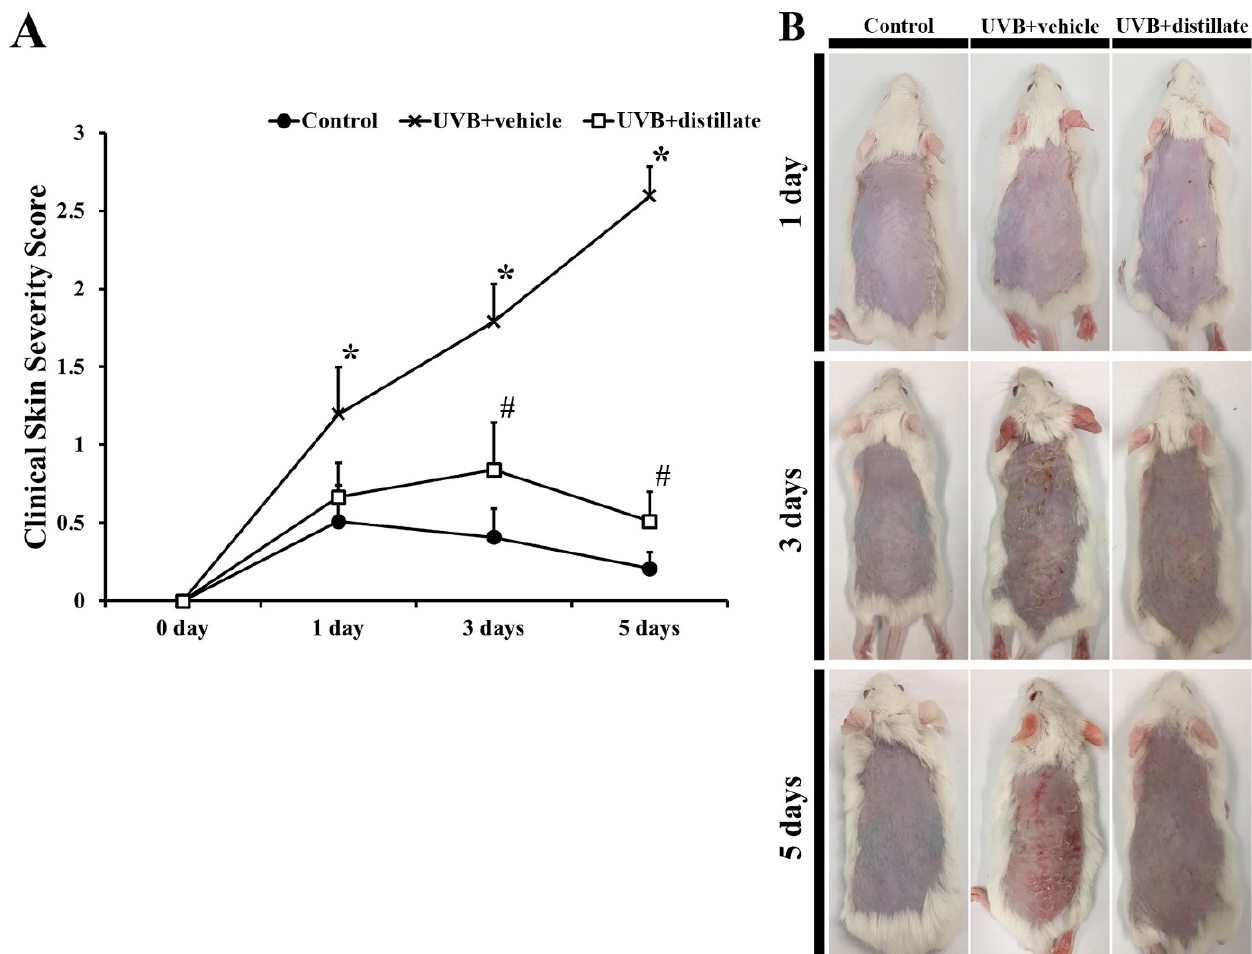
Figure 2. ( A ) The clinical skin severity score observed in the control, UVB + vehicle, and UVB + distillate groups at 1 day, 3 days, and 5 days after UVB exposure. The clinical skin severity score in the UVB + vehicle group was significantly increased from 1 day after UVB irradiation, however, the score in the UVB + distillate group was significantly decreased from 3 days to 5 days after UVB exposure compared to that in the UVB + vehicle group. The data represent mean ± standard errors of means ( n = 10/group, * p < 0.05 vs. control group; # p < 0.05 vs. UVB + vehicle group). ( B ) Photos of the dorsal skin of the control, UVB + vehicle, and UVB + distillate groups at 1 day, 3 days, 5 days, and 7 days after UVB exposure.